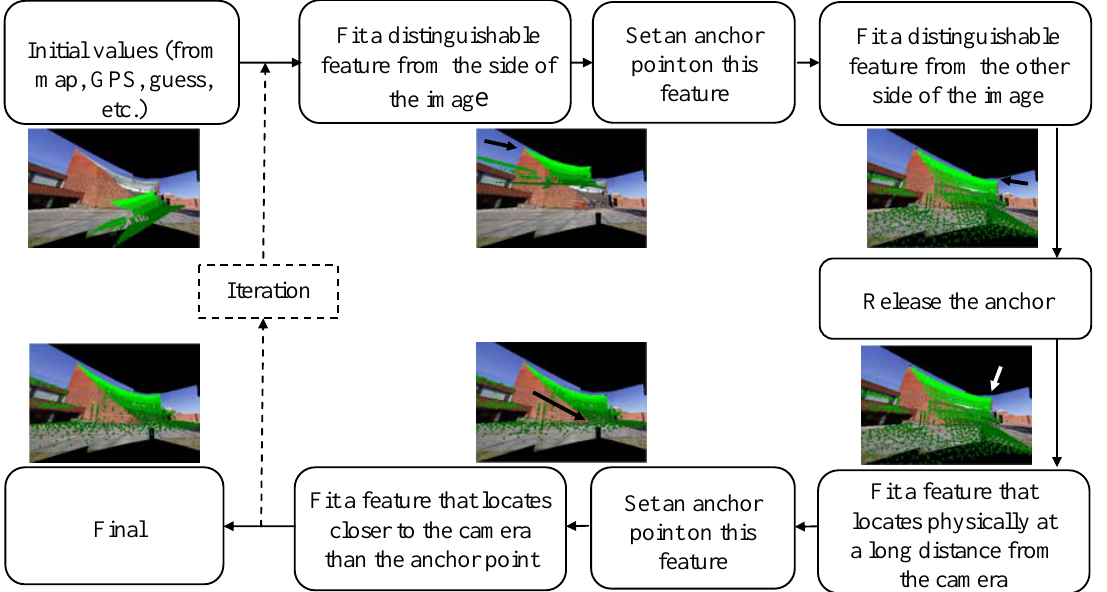
Figure 5. A suggestive workflow for an interactive orientation of a single